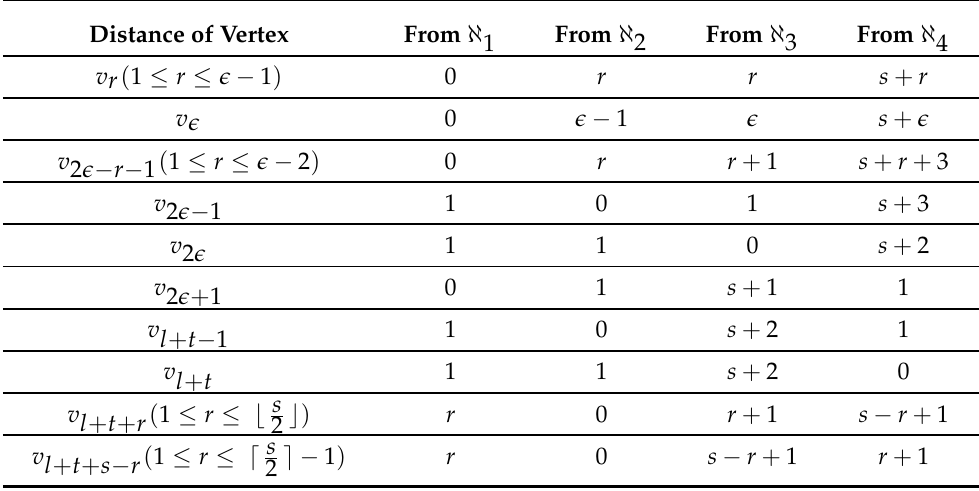
Table 6. Distance codes of V ( KP ( l , t , s )) with respect to ℵ for l = 2 (cid:101) , where, (cid:101) ≥ 2, and t = 2 b + 1, where b ≥ 2. Distance of Vertex From ℵ 1 From ℵ 2 From ℵ 3 From ℵ